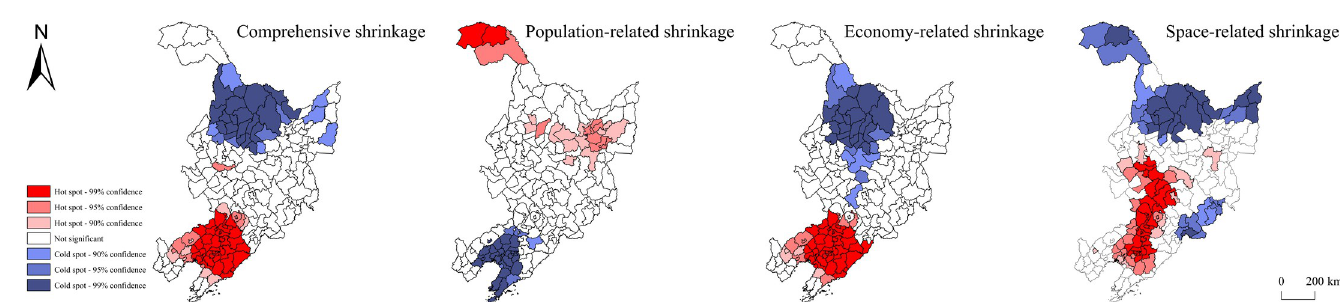
Fig 6. Cold-hot spots of regional shrinkage of the three northeastern provinces from 2012 to 2018. Note: The basic map came from a public map from the standard map service website of the Ministry of Natural Resources of China. The drawing approval number is GS (2016)1593.